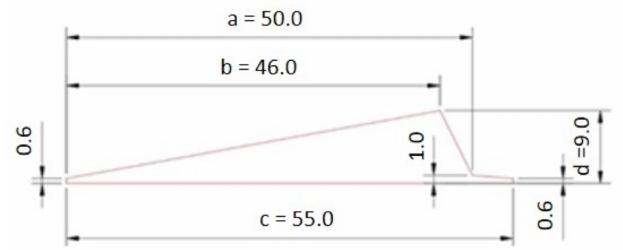
Figure 4. Model assembly.